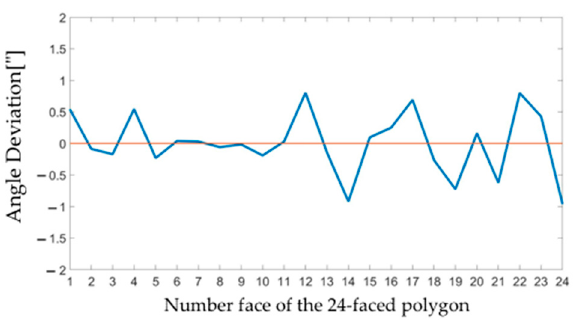
Figure 6. Calibration results for pitch angle deviations of the 24-faced polygon.